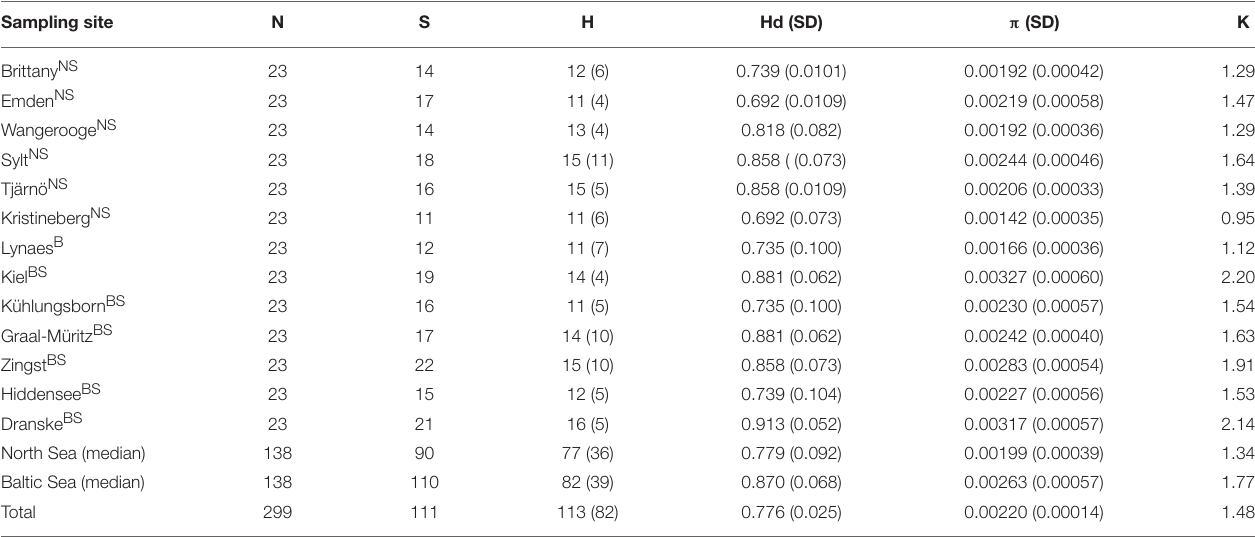
TABLE 2 | Population genetic indices for all sampling